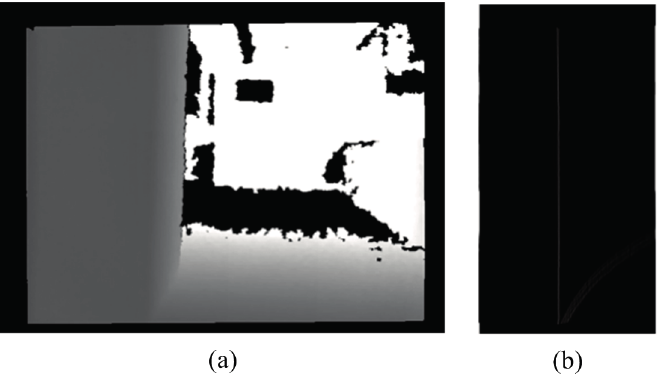
Figure 3. The relationship between the depth map and the V-disparity. ( a ) Depth map; ( b )